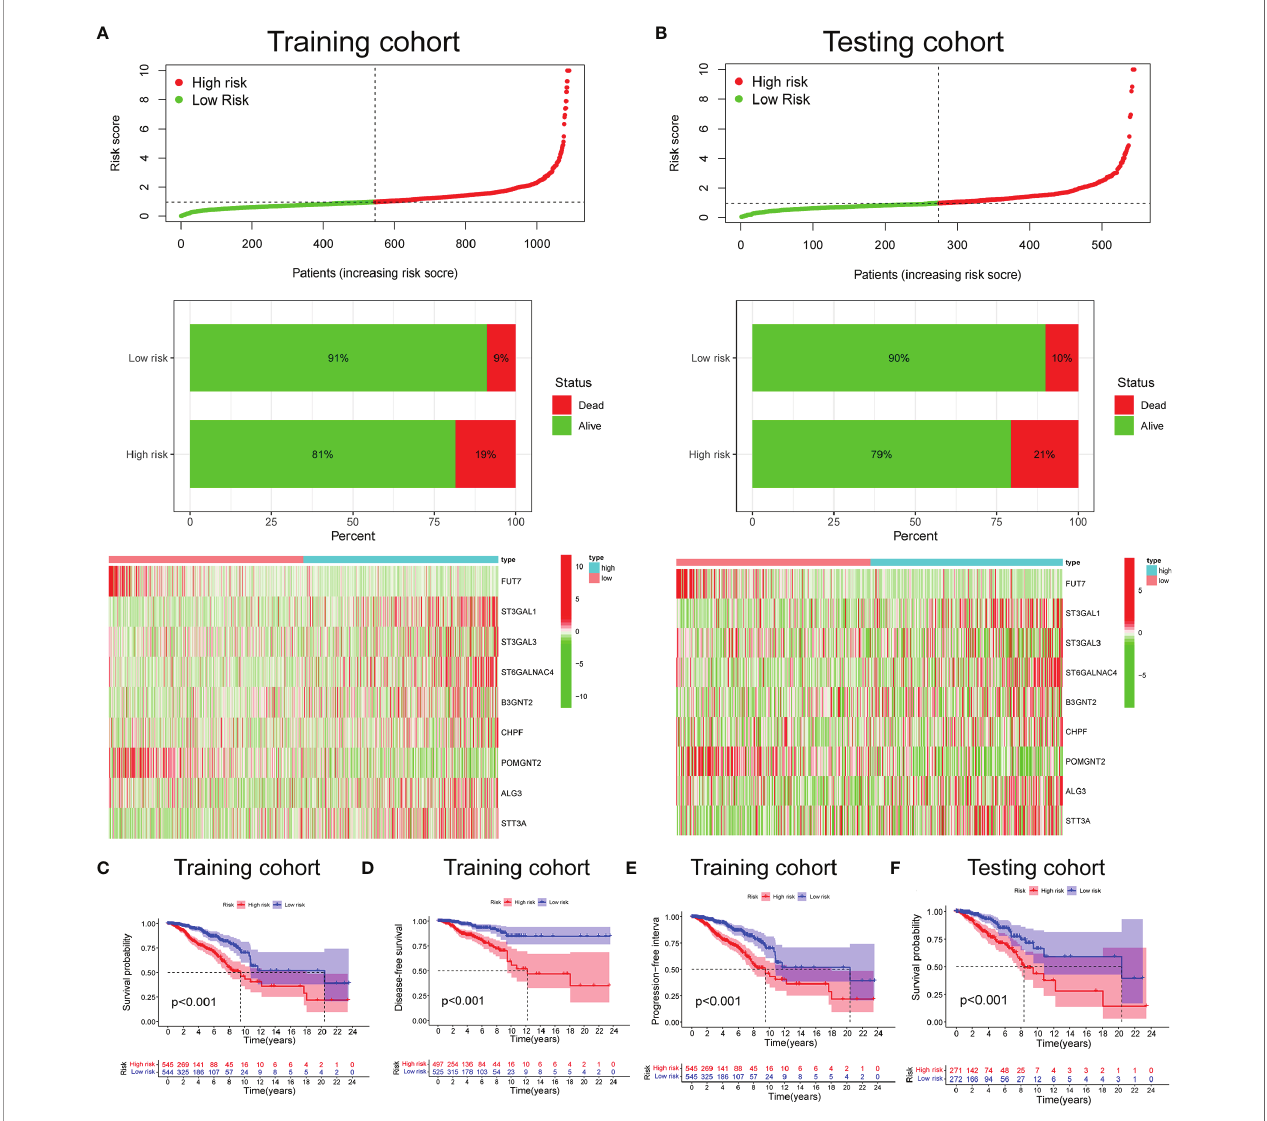
FIGURE 2 | Prognosis and expression of glycosyltransferase genes in the low-risk and high-risk groups of BC patients. Risk plot distribution, survival status, and expression of risk genes of the training set (A) and validation set (B) . KM survival curve analysis of OS (C) , disease-free survival (D) , and progression-free interval (E) in the training set. (F) KM survival curve in the testing set. BC, breast cancer; KM, Kaplan – Meier; OS, overall